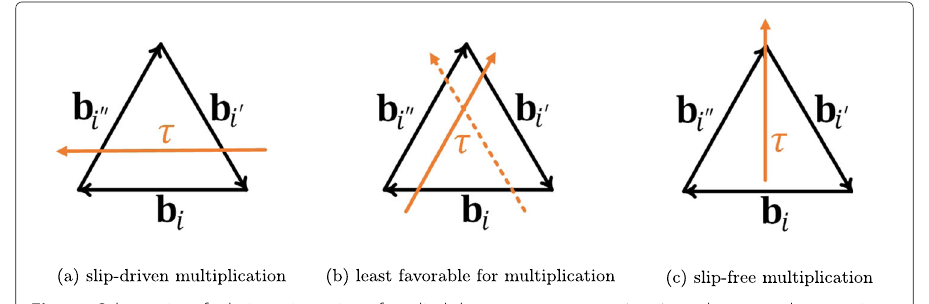
Fig. 11 Schematics of relative orientation of applied shear stress, τ = t − ( t · n ) n , where n and t are unit vectors denoting the normal to plane containing slip systems i , i (cid:8) and i (cid:8)(cid:8) , and the loading orientation, respectively. a S i = S i max corresponding to rightmost boundary of blue data points in Fig. 4b; in this case system i experiences slip-driven (i.e. regular) multiplication. b S i − 0.5 S i max = 0 corresponding to the boundary between blue and red data points in Fig. 4b; in this case multiplication on system i is minimum. c